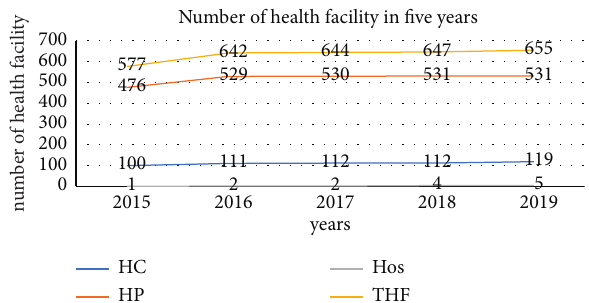
Figure 7: Number of health facilities expected to be reported by year in the Jimma Zone, Oromia Region, from 2015 to